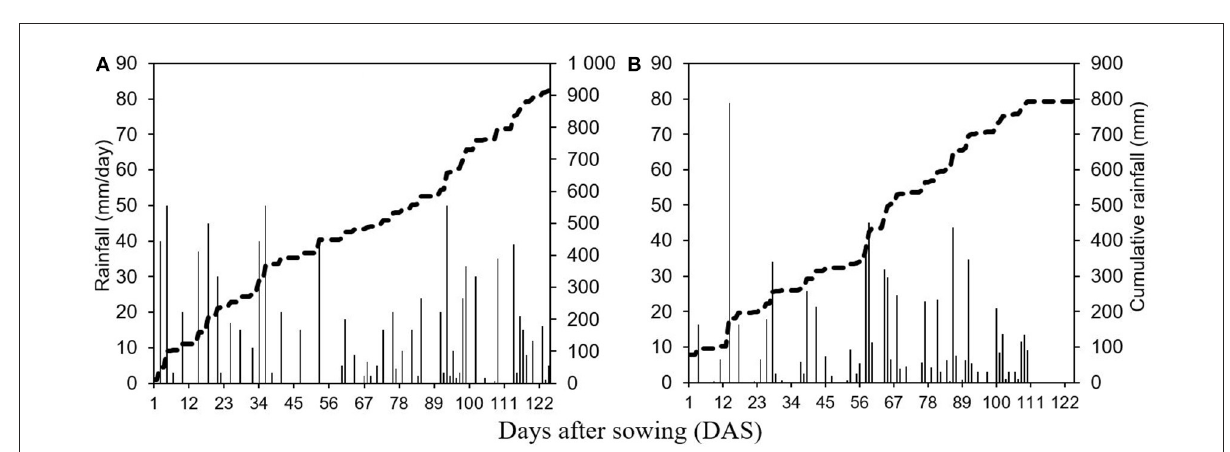
FIGURE2 Rainfall distribution under on-station experiments: (A) Parakou and (B)